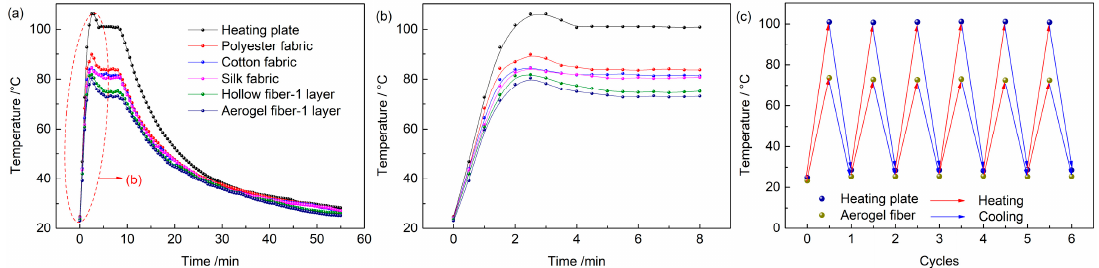
Figure 7. The dynamic thermal insulation properties of different textiles. ( a ) Temperature-time curves of the different textiles. ( b ) Temperature-time curves of the different textiles in the first 8 min. ( c ) When the heating plate is cyclically heated up at a constant rate and air-cooled down between 28 and 100 °C, the aerogel fiber mat surface also cycles but within a much narrower range between 26 and 73 °C.